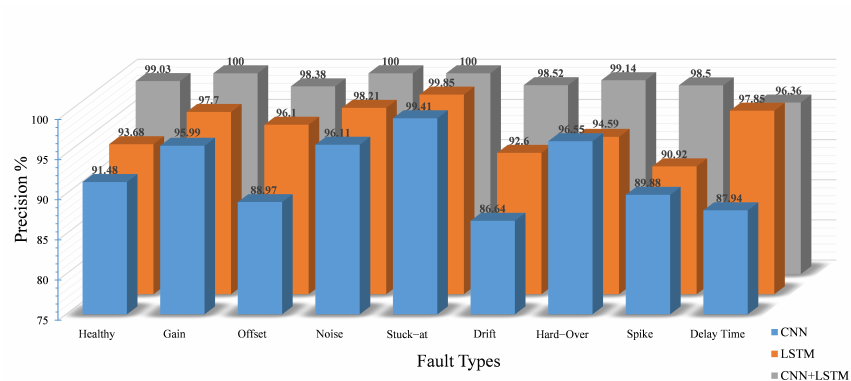
Figure 12. Classification performance in terms of precision.